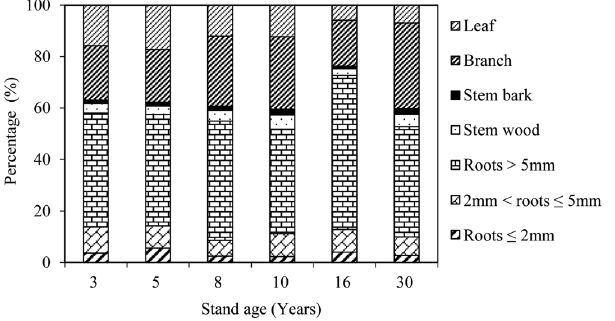
Figure 1. Proportion of the biomass of different components in the C. intermedia plantation stands at different ages (%).